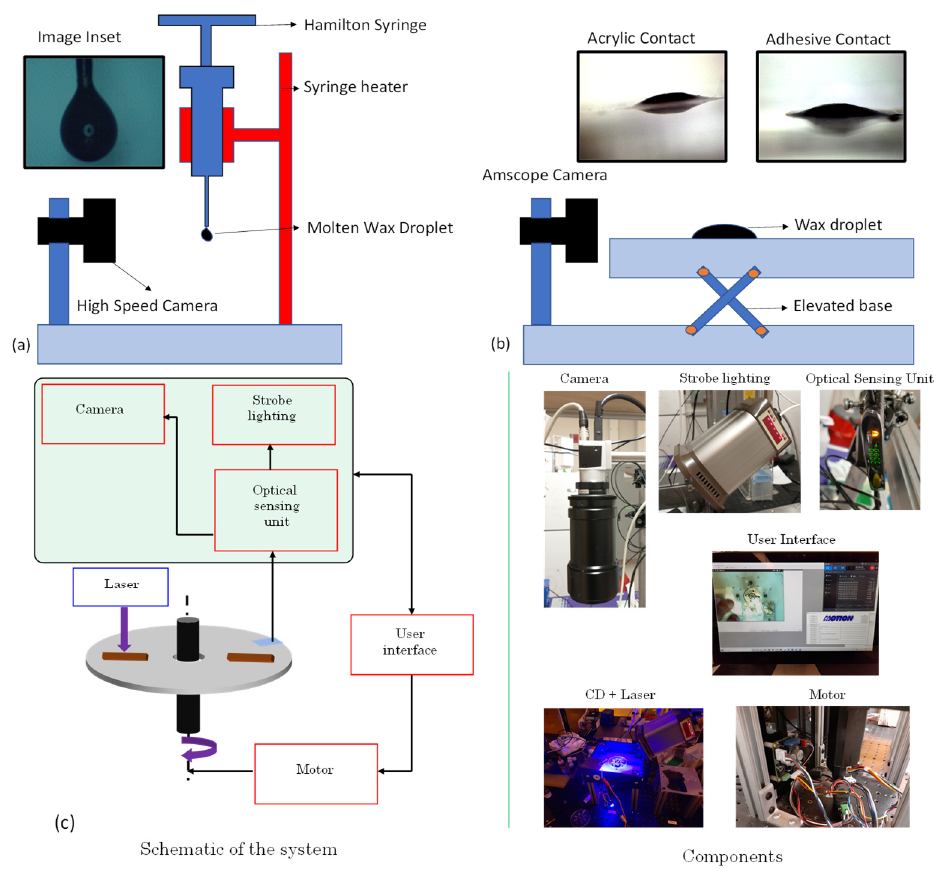
Figure 2. Ferrowax property measurement and characterization setup: ( a ) Viscosity measurement setup: High-speed camera Kron Technologies 18W15 (Burnaby, BC, Canada) takes images of pendant drops of the molten ferrowax (see inset) suspended from the needle of the heated Hamilton syringe. Images of the droplets are processed via ImageJ Pendant Drop Plugin [21] to determine the surface tension of the ferrowax. ( b ) Contact angle measurement setup: Amscope MA1000 camera (Irvine, CA, USA) takes pictures (see insets) of the ferrowax drops on various surfaces, such as on adhesive film and acrylic plastic (inset) and images are processed with ImageJ software (contact angle plugin) [22] to determine the corresponding contact angles of ferrowax with different